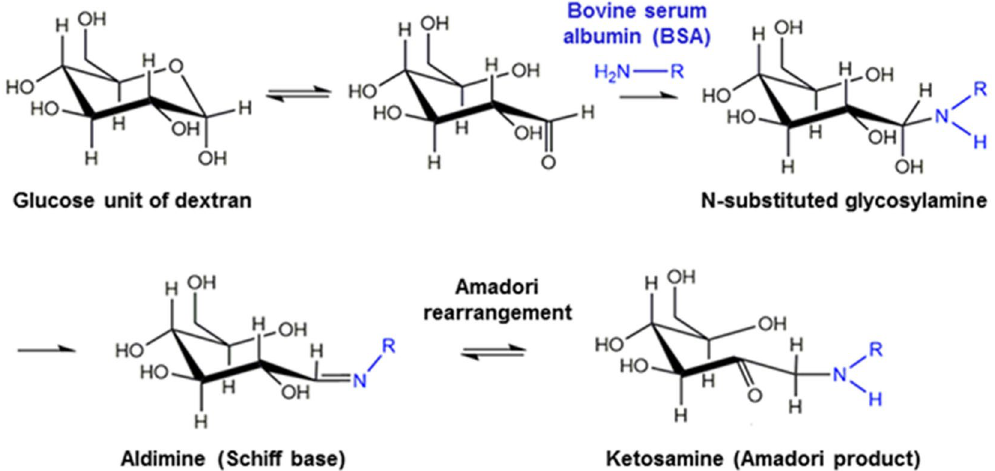
Figure 1. Schematic representation of Maillard conjugation reaction between glucose unit in dextran and bovine serum albumin